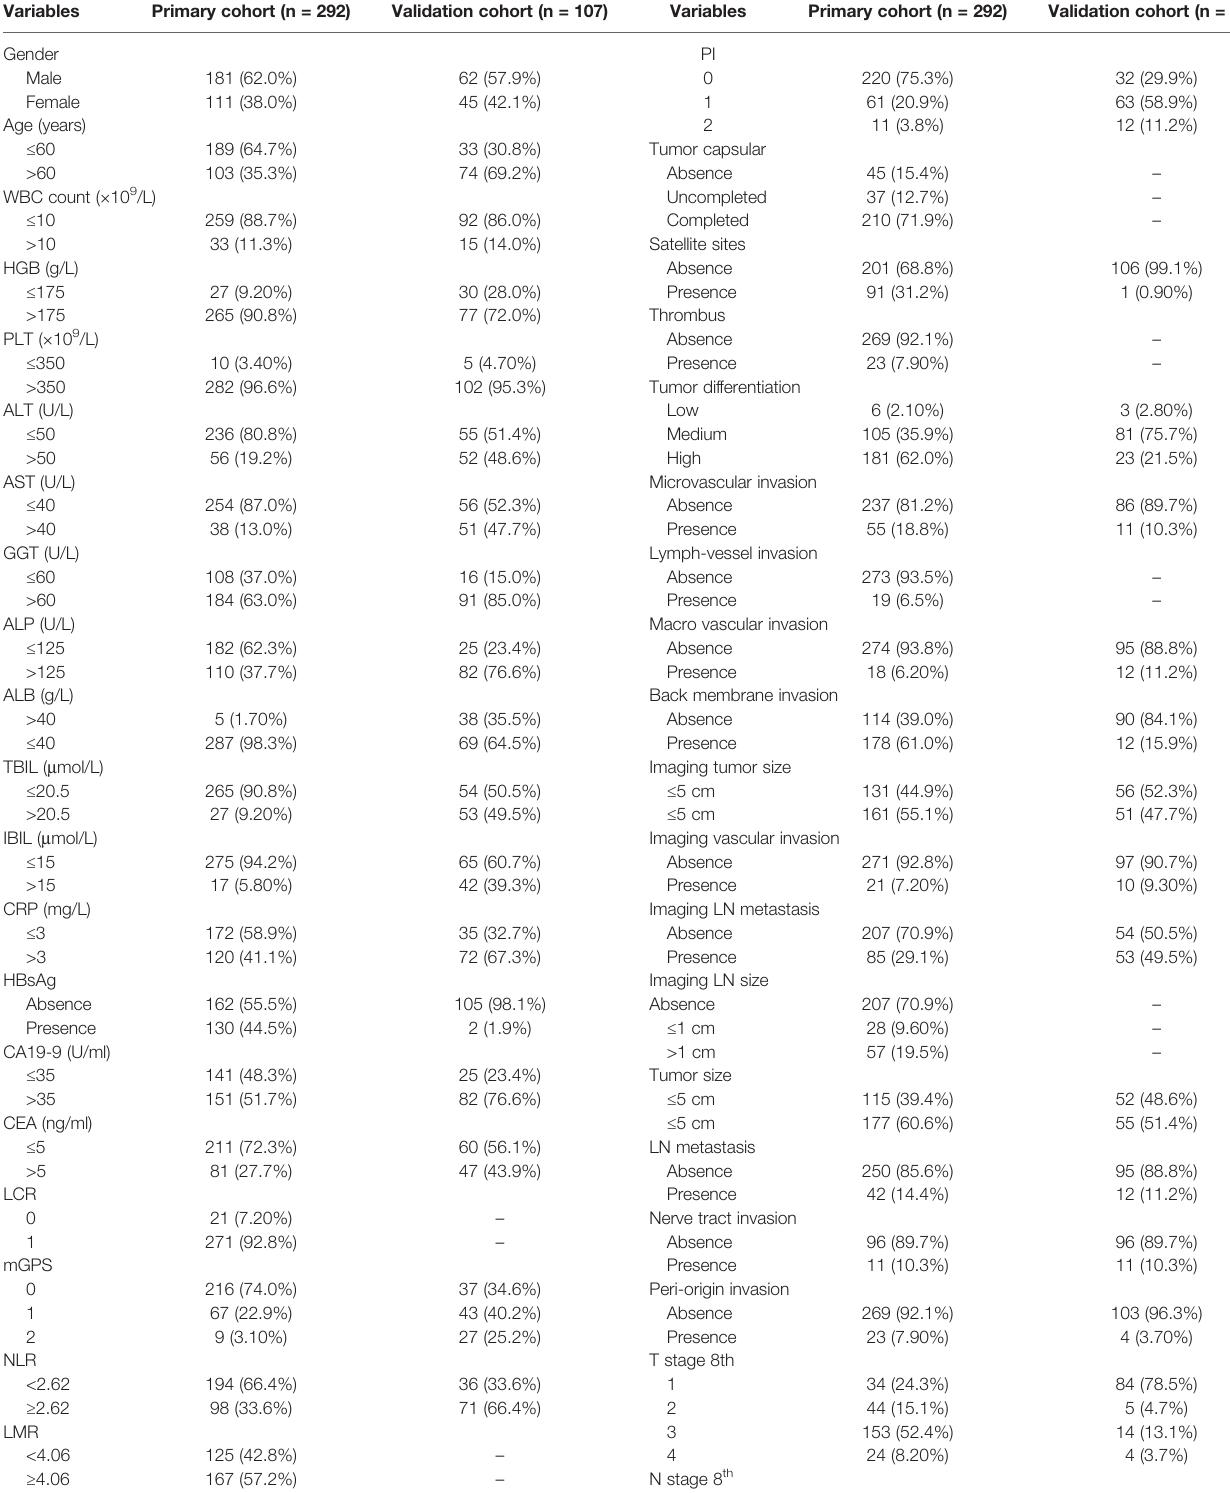
TABLE 1 | Clinical, radiological, and pathological characteristics of the SYSUCC cohort and FHDMU cohort.